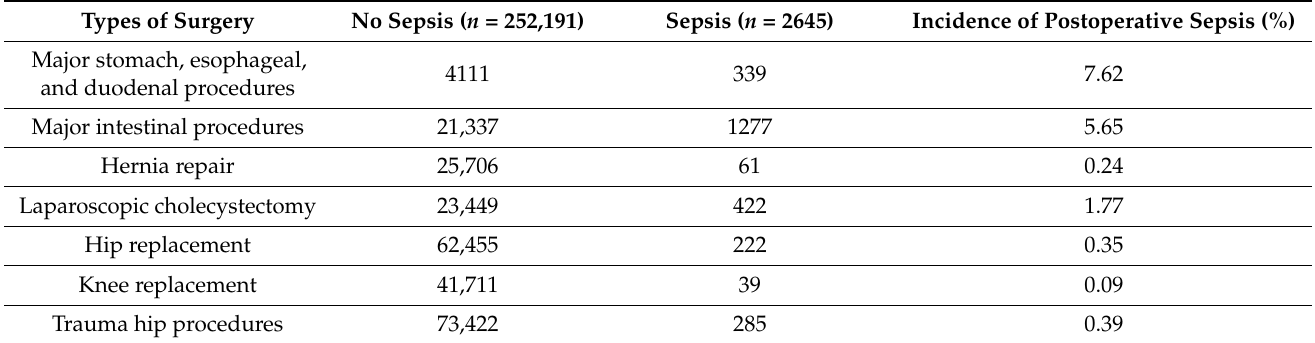
Table 2. Selected Diagnosis-Related Groups in the patient population ( n = 254,836).